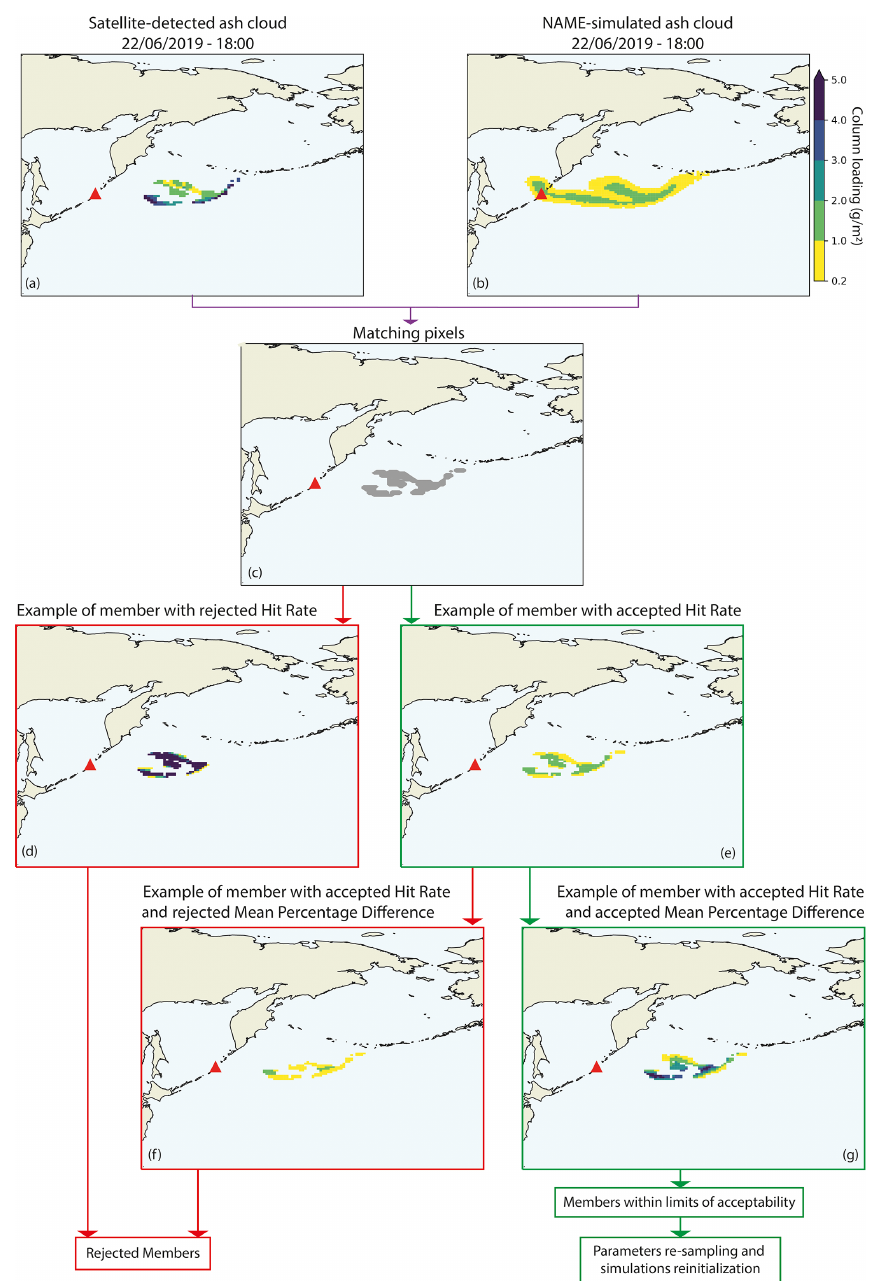
Figure 3. Ash column loading at 18:00UTC on 22 June 2019, (a) as detected by the satellite, (b) NAME simulation of one ensemble member in NAME, and (c) after pixel-matching (grey pixels represent a match between satellite and simulation). Examples of ensemble members rejected depending on values of hit rate and mean percentage difference (red boxes) are shown in (d) and (f) . Examples of accepted ensemble members depending on values of hit rate and mean percentage difference (green boxes) are shown in (e) and (g) . All panels except (c) use the colour scale shown in (b) . The red triangle in each panel shows the location of